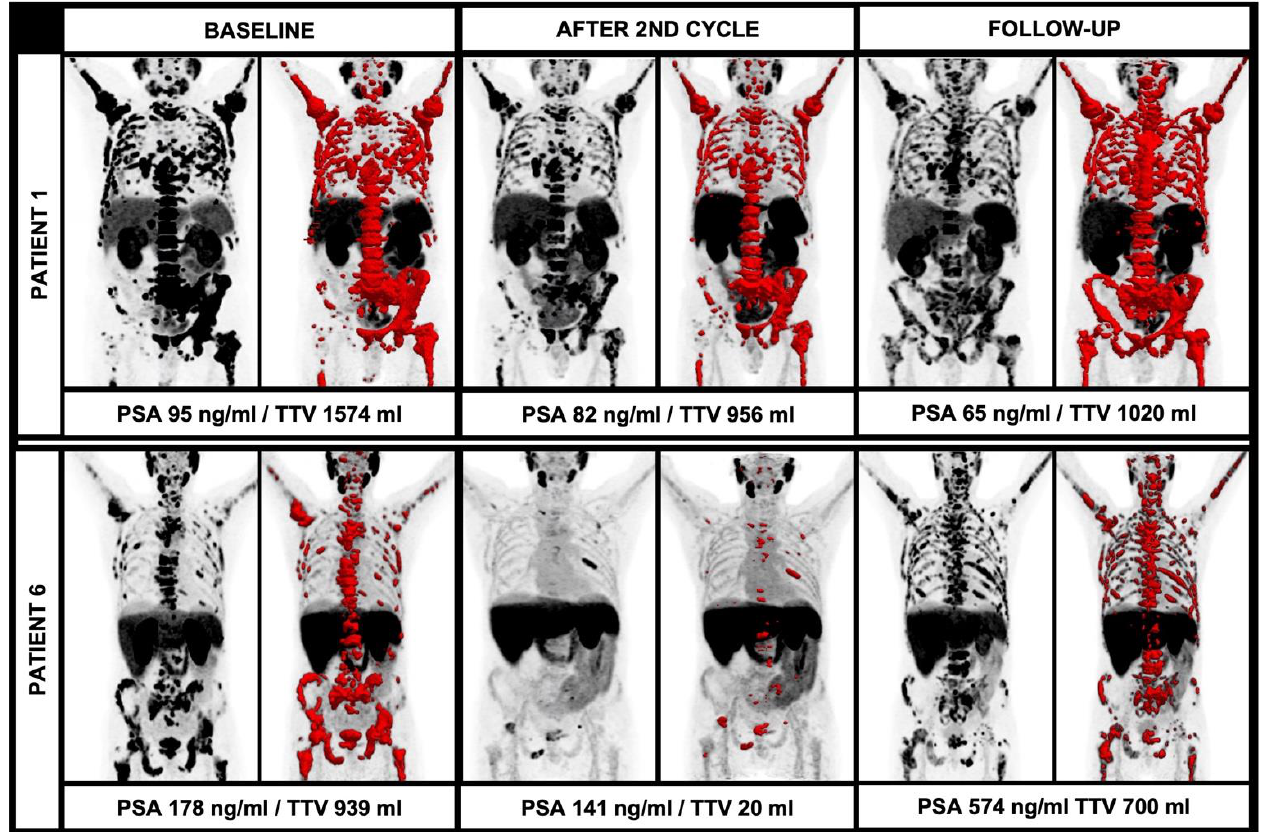
Figure 4. Diverging course of TTV with newly occurring lesions during alpha therapy. While patient 1 had a stable TTV and decreasing PSA during therapy despite new PSMA-avid lesions, patient 6 had new PSMA-avid lesions with an extensive increase of TTV and PSA.